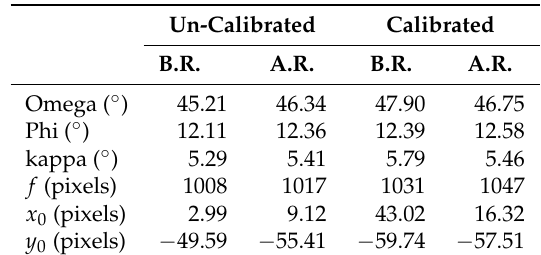
Figure 16. An illustration of three orthogonal vanishing points detected from the video frame cut; vanishing points linked to grouped line segments along X , Y , Z direction are marked in red, green, and blue, respectively. Table 2. The comparison of interior orientation parameters (IOPs) and exterior orientation parameters (EOPs) before and after the proposed vanishing point refinement processing of the raw image and the radial distortion calibrated